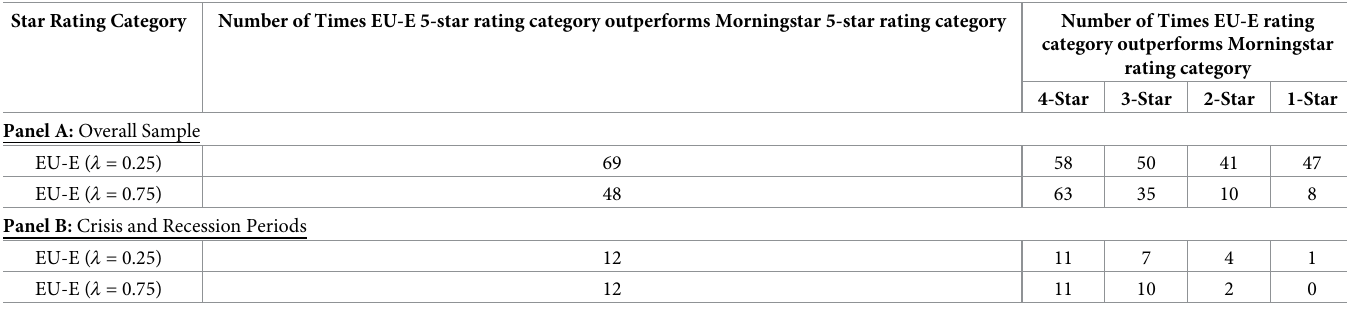
Table 10. Comparison of the predictive ability of ratings based on the EU-E model with Morningstar ratings measured across performance metrics. Star Rating